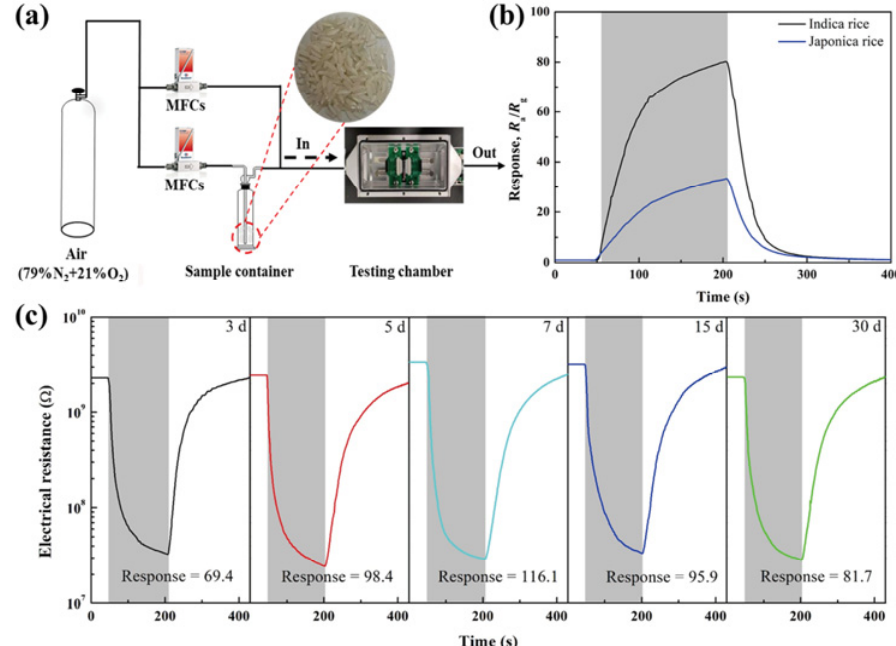
Fig. 7 (a) Schematic diagram of the sensor testing system for detecting VOCs generated from 30 g Indica and Japonica rice; (b) response measured under exposure to VOCs generated from two rice aging; and (c) response towards VOCs generated from 30 g Indica rice stored in various